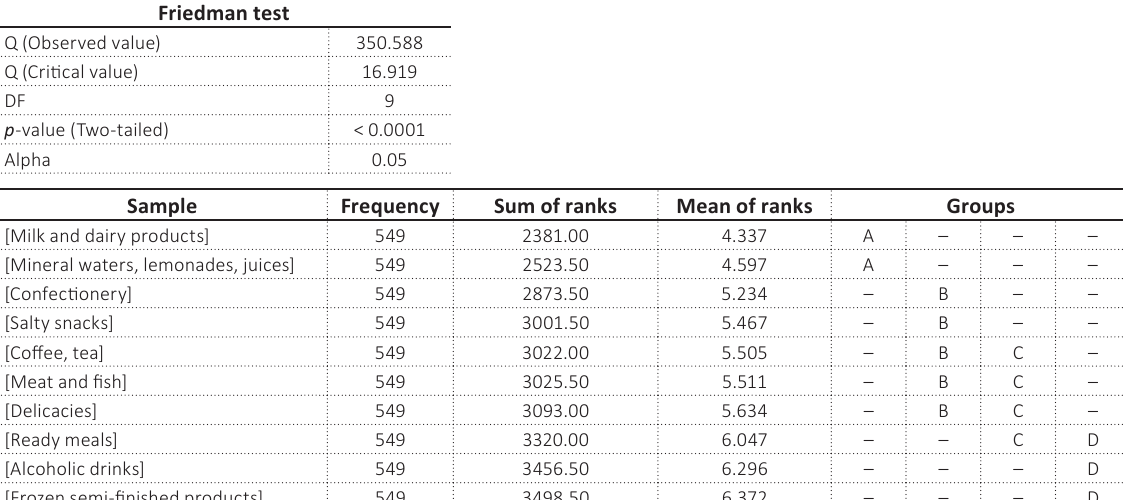
Table 3. Friedman test